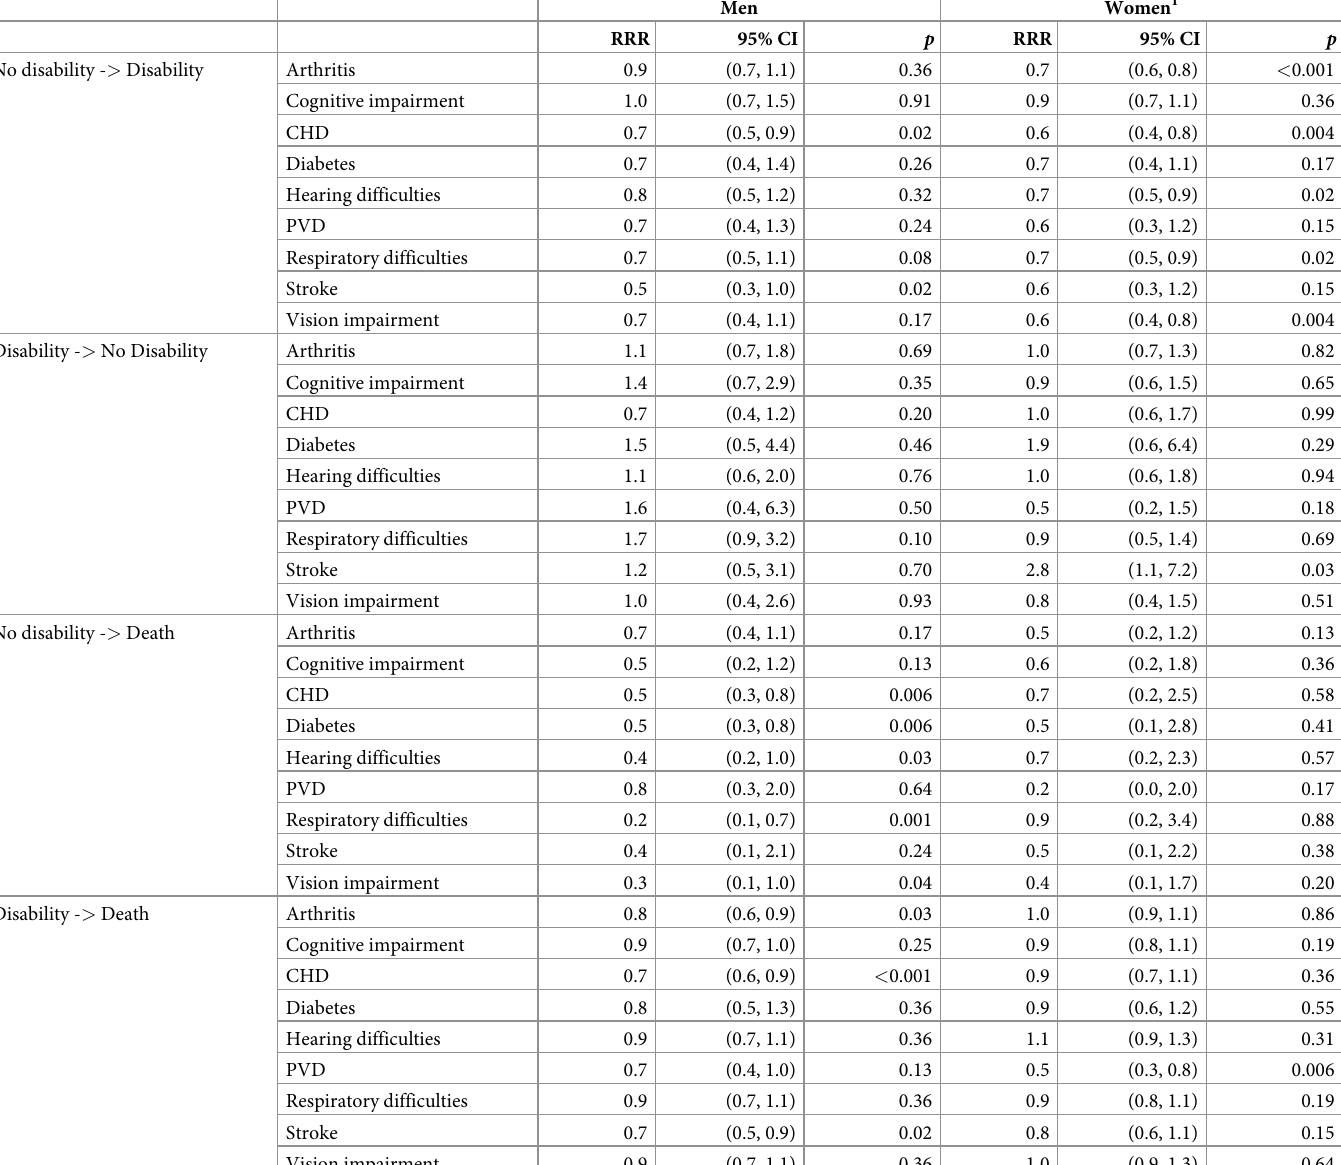
Table 3. RRR of transitioning between disability states in the CFAS II (2011) compared to CFAS I (1991) for men and women with each LTC, with 95% CIs and p - values (p). Estimates from models stratified by sex and health condition with age and study